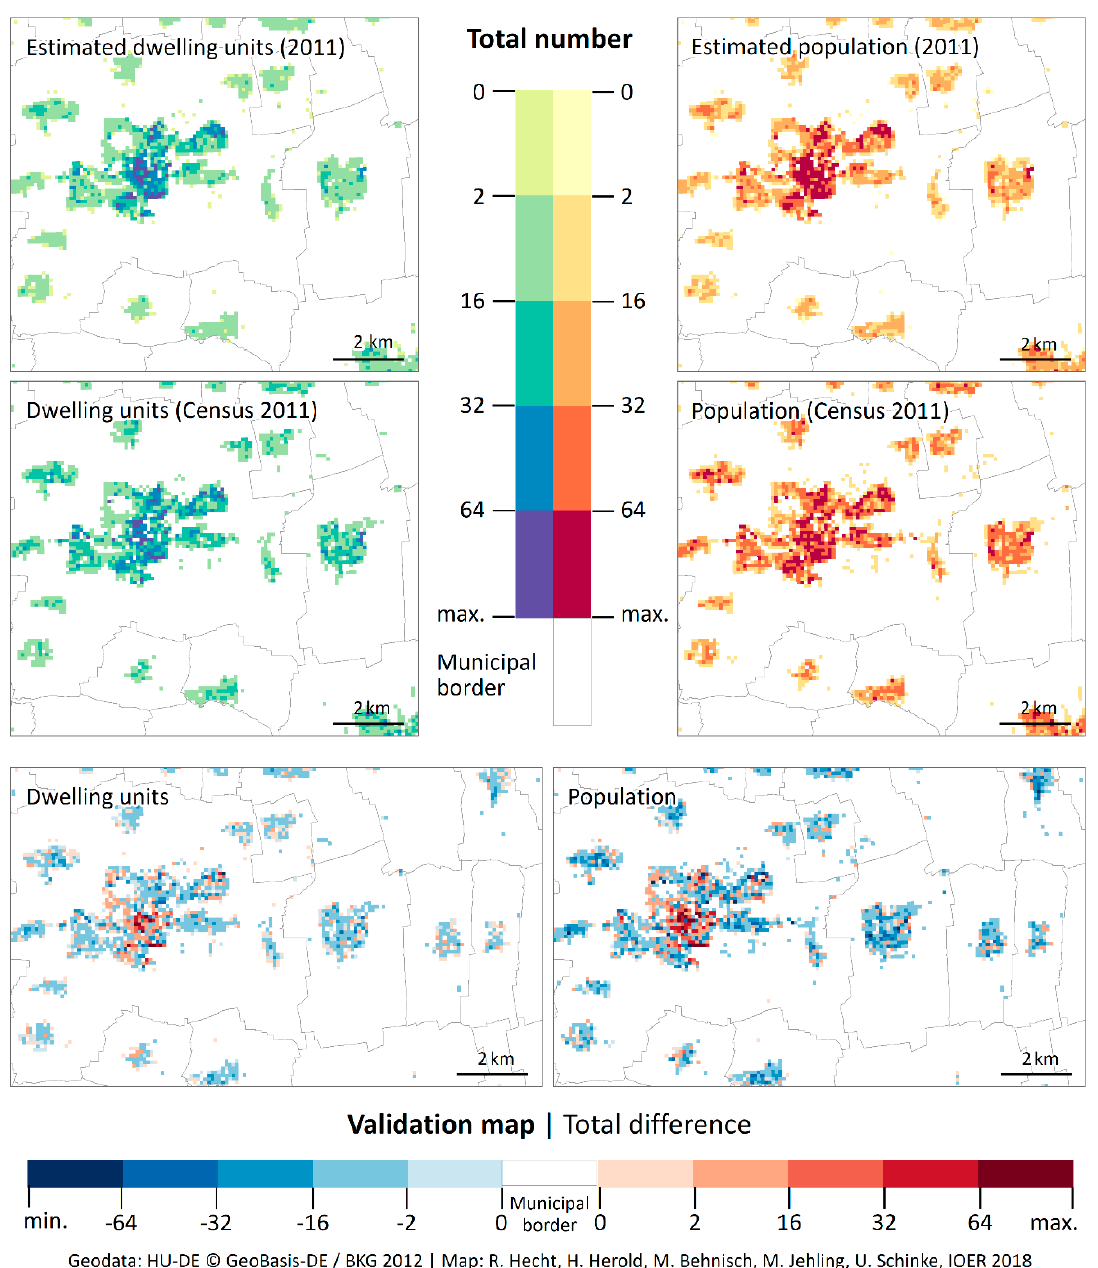
Figure A3. Derived dwelling units and population in comparison to the reference values and the calculated difference at the level of 100 m grid cells.